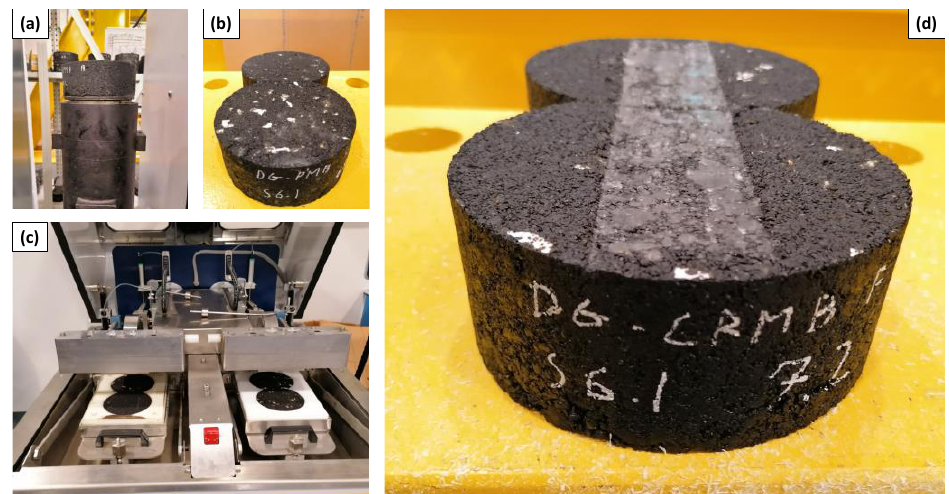
Figure 4. HWT sample preparation and testing: (a) GSC sample, (b) couple of samples with straight face by side, (c) HWT setup, (d) sample after test.